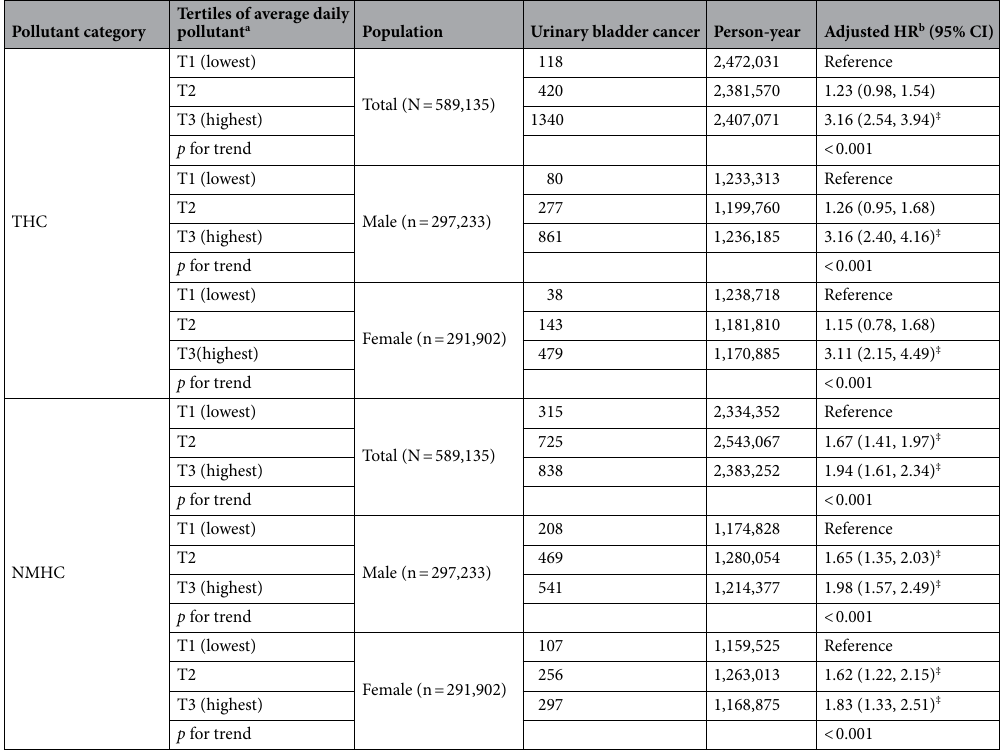
Table 4. Cox regression-derived adjusted hazard ratios for incident urinary bladder cancer associated with each tertile of ambient THC or NMHC exposure stratified by sex. HR hazard ratio, CI confidence interval, THC total hydrocarbons, NMHC nonmethane hydrocarbons. a The tertile values, in ppm (THC, NMHC), are as follows: THC (T1: < 2.17, T2: ≥ 2.17 and < 2.32, and T3: ≥ 2.32); NMHC (T1: < 0.25, T2: ≥ 0.25 and < 0.33, and T3: ≥ 0.33). b Cox regression models were adjusted for age, sex, level of urbanization, the black-foot disease endemic region, essential hypertension, chronic cystitis, smoking-related diagnoses, alcohol use disorders, morbid obesity, spinal cord injury, chronic liver disease, diabetes mellitus, gout, chronic kidney disease, pesticide exposures, dyslipidemia, lag0–2, season, and ambient temperature. ‡ p <